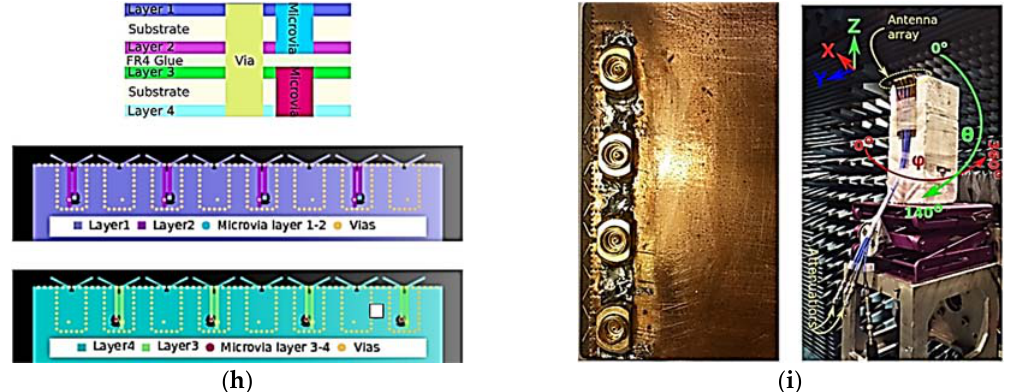
Figure 6. ( a ) Three-dimensional (3D) illustration of proposed antenna element. ( b ) Electric fields of proposed antenna’s modes: top view ( left ) and bottom view ( right ). ( c ) Geometry of proposed eight-element phased-array antenna. ( d ) S-parameters of proposed phased-array antenna. ( e ) 3D radiation patterns of proposed phased array in all modes. ( f ) 3D view of antenna and MMPX feeding structure. ( g ) Simulated and measured 3D radiation patterns at different scanning angles at 25, 27, 29, and 31 GHz. ( h ) Overview of the layers in the antenna structure. ( i ) Prototype of the phased-array antenna. (Redrawn from [42])